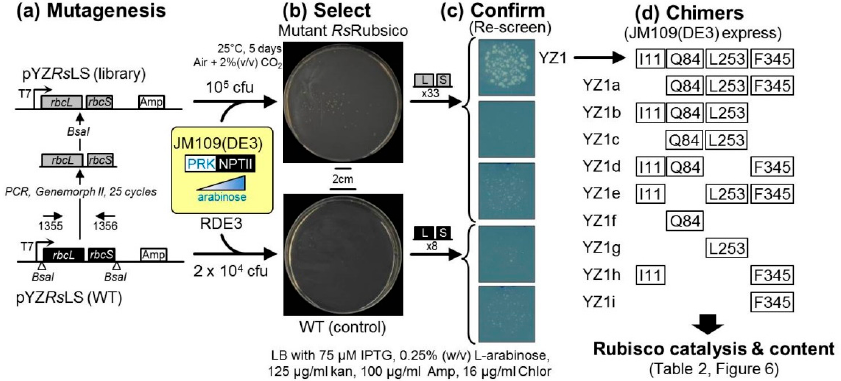
Figure 5. RDE3 evolution of Rs Rubisco. ( a ) Wild-type (WT) and a mutated Rs–rbcLS operon library cloned into pYZ Rs LS were transformed into RDE3 and ( b ) screened under strong arabinose selection as shown. The surviving colonies were grown (under non-selective conditions), the pYZ Rs LS purified and those containing the Rs–rbcLS operon re-transformed into RDE3 and ( c ) re-grown on selection media (examples for five of the 41 RDE3 re-screens are shown). Only the YZ1 mutant improved RDE3 growth, and ( d ) the sequencing of its Rs–rbcLS operon showed that it coded RbcL mutations V11L, K84Q, R253L and Y345F (plant RbcL numbering, Table A1). Nine YZ1 chimers (named YZ1a to YZ1i) coding di ff ering combinations of these mutations were created to study how they influence Rs Rubisco biogenesis (Figure 6) and catalysis (Table 2). Table 2. Comparative E. coli biogenesis (solubility) and catalysis (at 25 ◦ C) of wild-type, YZ1 and their Rs Rubisco chimers. RbcL Residue Number Rs Rubisco Isoform